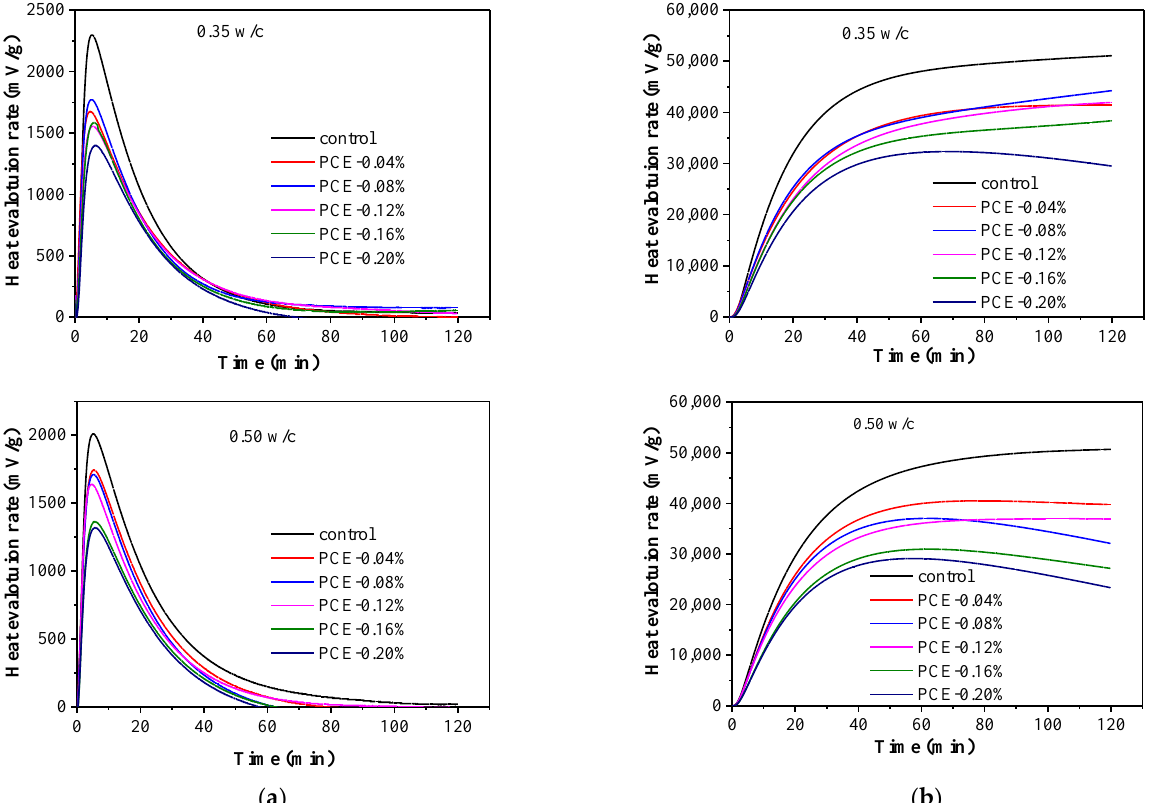
Figure 14. Calorimetry curves of cement pastes in the presence of PCEs at various dosages at 25 °C: ( a ) differential heat flow and ( b ) cumulative heat flow.